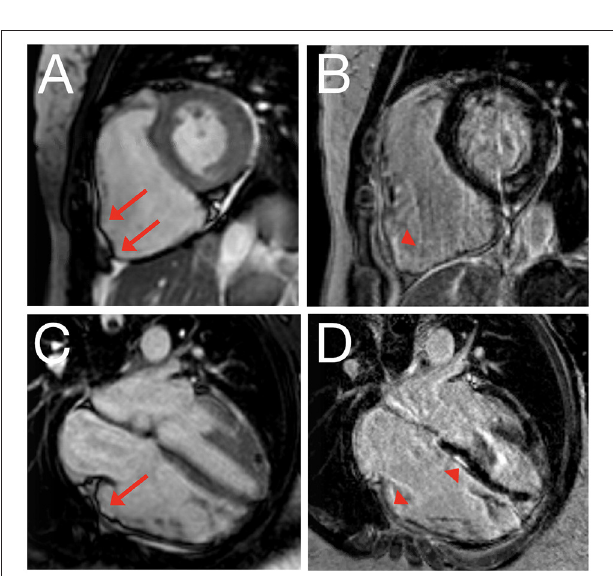
FIGURE 3 | Cardiac magnetic resonance imaging of 22-year old female with ARVC. Still image of cine clip for short axis (A) and long axis (C) view, with corresponding delayed enhancement images obtained using phase-sensitive inversion recovery in short axis (B) and long axis (D) view. Red arrows denote dyskinetic segments with outward bulging in systole; arrowheads denote corresponding delayed